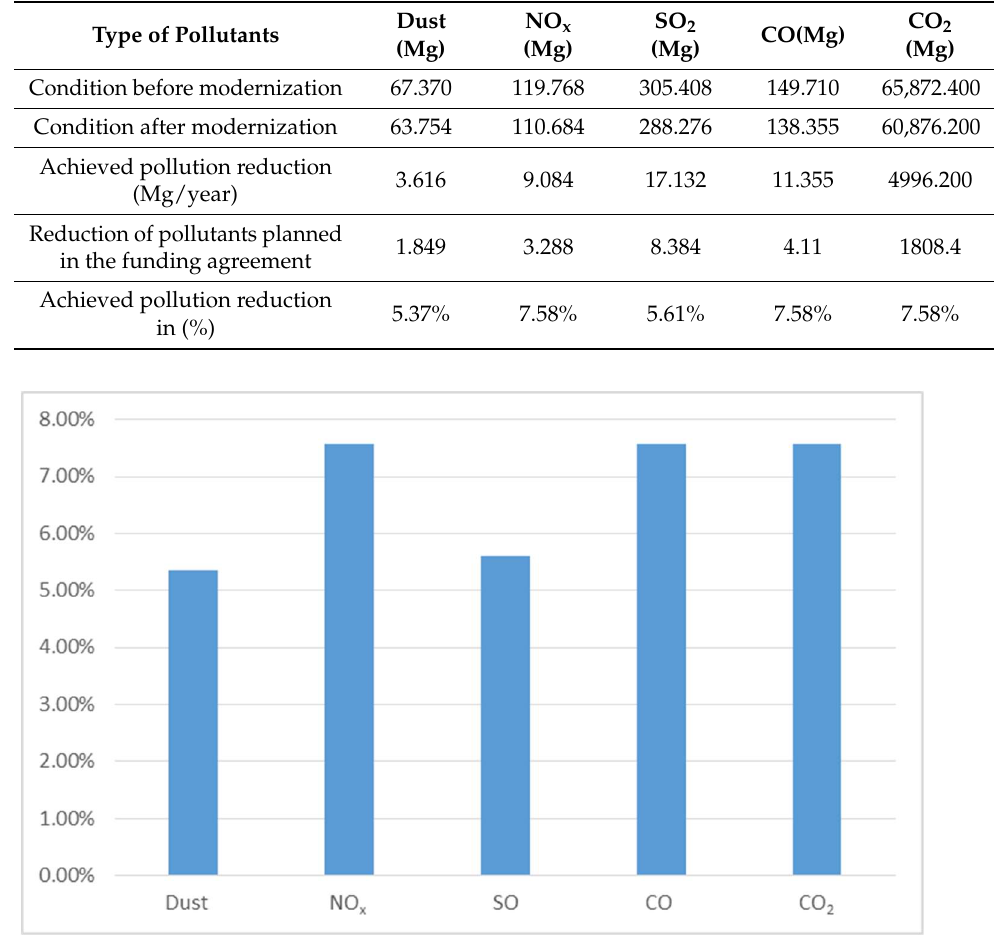
Figure 3. Achieved pollution reduction in particular pollutants in percentages. SO 2